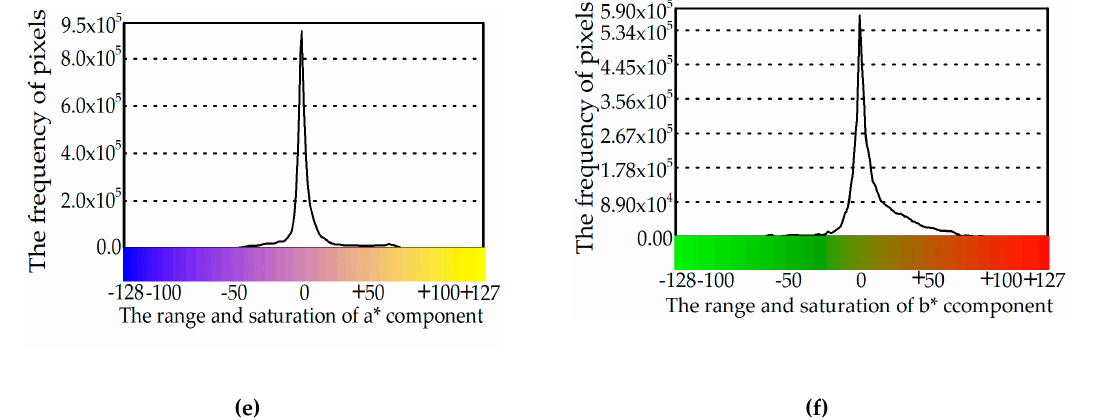
Figure 1. The frequency of pixels on Stex and its subsets: ( a , b ) Stex, ( c , d ) 50% of Stex, and ( e , f ) 10% of Stex.